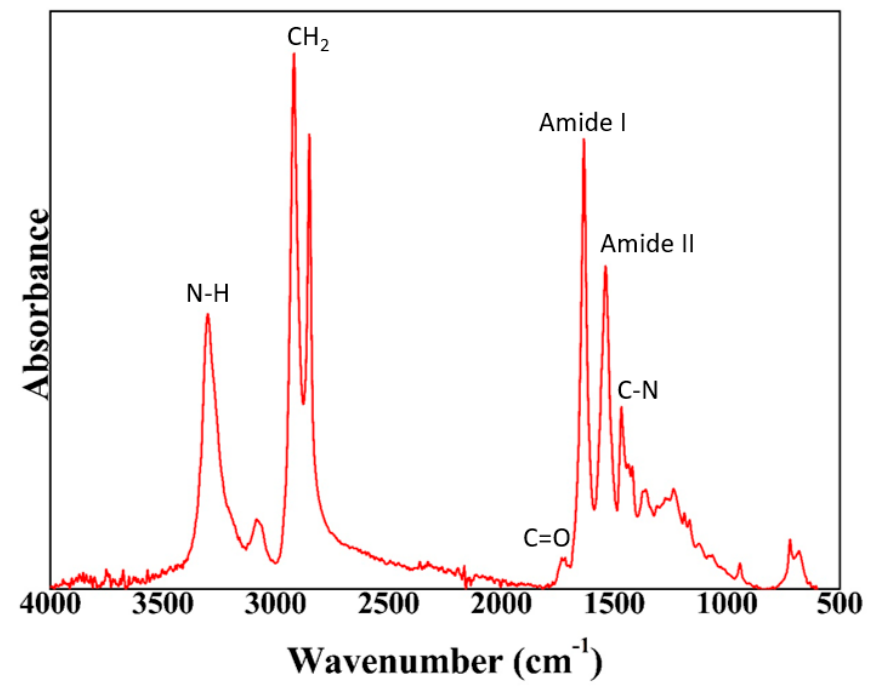
Figure 2. FTIR spectrum of the bio-based copolyamide PA1010/1014.